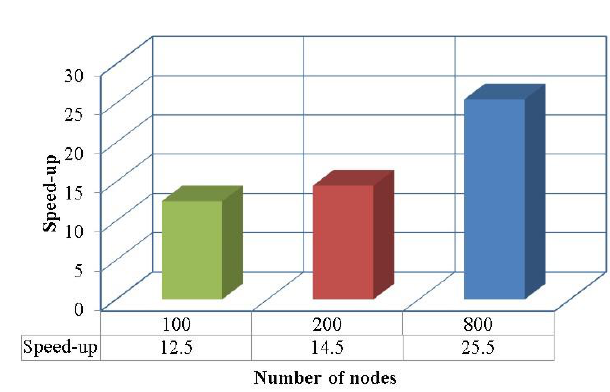
Figure 3 . Comparison of speed-up of parallelized software, for different number of nodes of the mesh for the membrane of the deformable